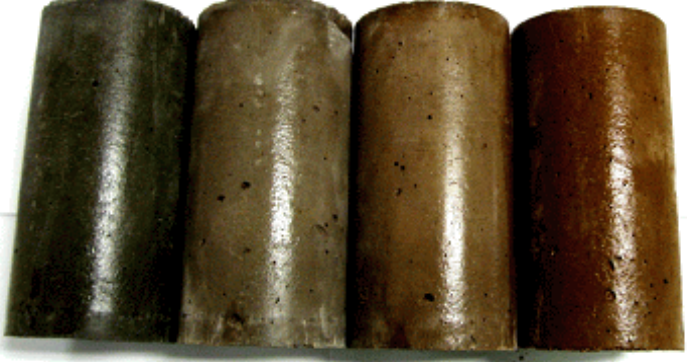
Figure 2. 100 mm × 200 mm Hwangtoh and slag cement concrete cylindrical